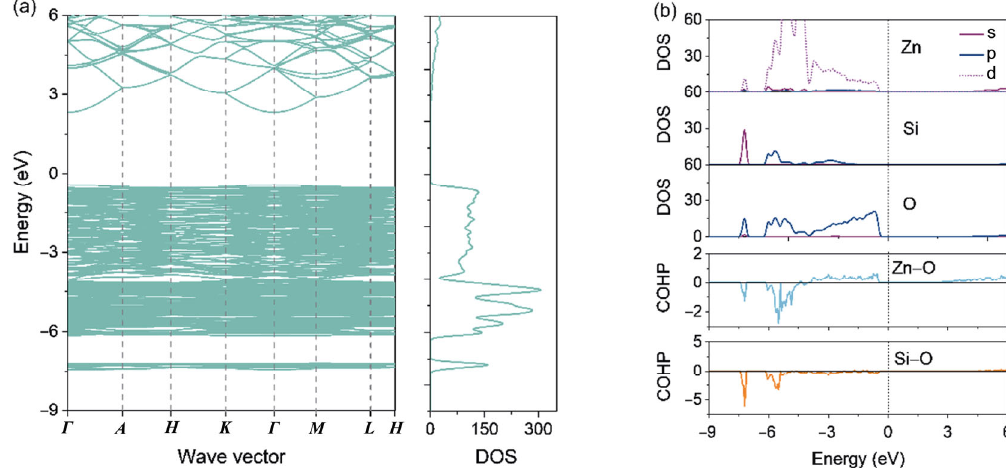
Fig. 2 Electronic structure of Zn 2 SiO 4 . (a) Band structure and total DOS and (b) PDOS and COHP.